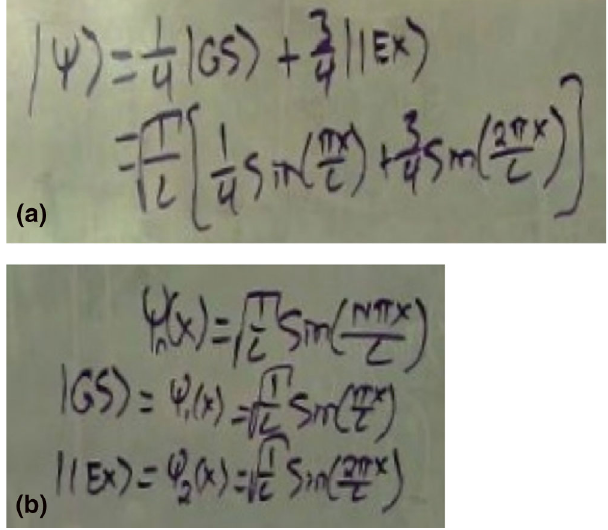
FIG. 2. Diego writes expressions with kets equal to wave functions in (a) the upper left of his whiteboard and (b) the lower right of his whiteboard. The first line in (a) was written first. Then the equations in (b) were written (in order from top to bottom). Finally, he wrote the second line in (a).